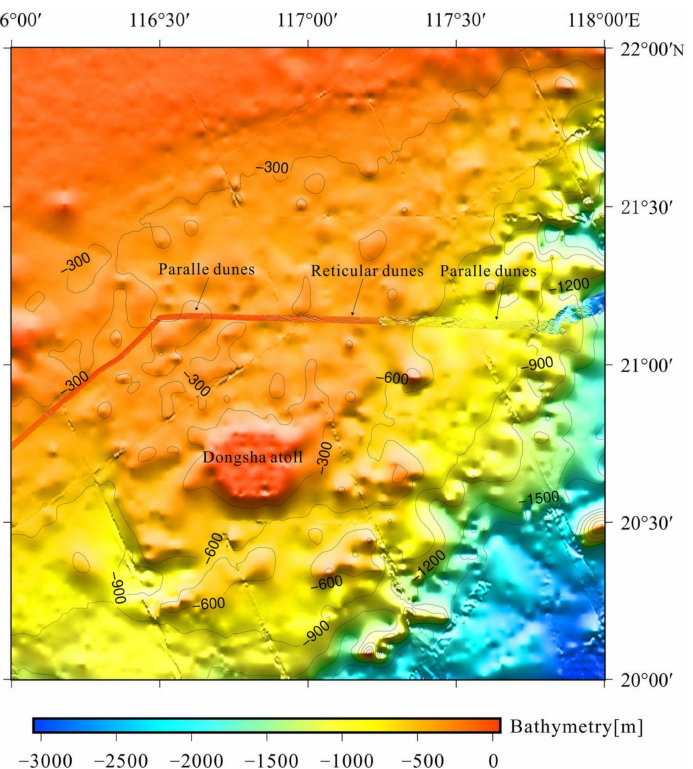
Figure 7. Multibeam echo-sounder bathymetry in the narrow track line showing the reticular dunes and parallel dunes, overlapped on the background bathymetric data from the General Bathymetric Chart of the Oceans [40]. The locations of the reticular dunes and parallel dunes are marked with